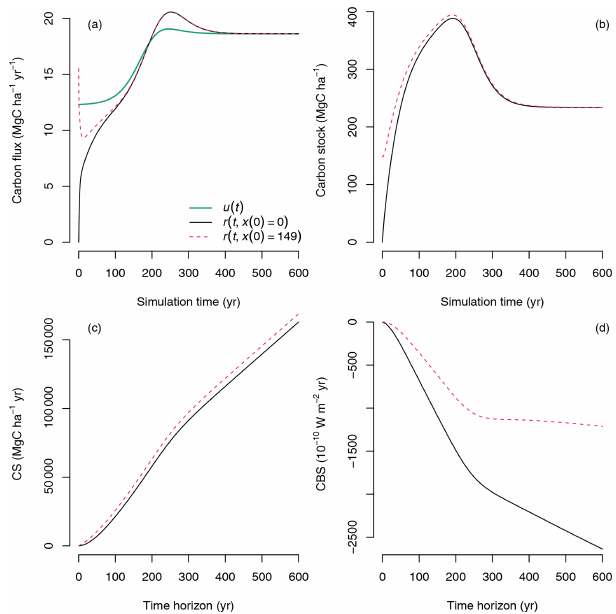
Figure 10. Computation of CS and CBS for continuous inputs and release of carbon in simulations with different initial conditions x 0 : in one simulation the ecosystem develops from empty pools ( x ( 0 ) = 0 , i.e., bare ground, black lines), and in the second simulation the ecosystem develops from existing litter and SOM pools but empty biomass pools ( (cid:107) x ( 0 ) (cid:107) = 149 . 04MgCha − 1 , dashed magenta color lines). (a) Inputs u (t) and release fluxes r(t) along the simulation time. (b) Carbon stocks predicted by the model along the simulation time. (c) Carbon sequestration CS for a sequence of time horizons. (d) Climate benefit of sequestration CBS for a sequence of time